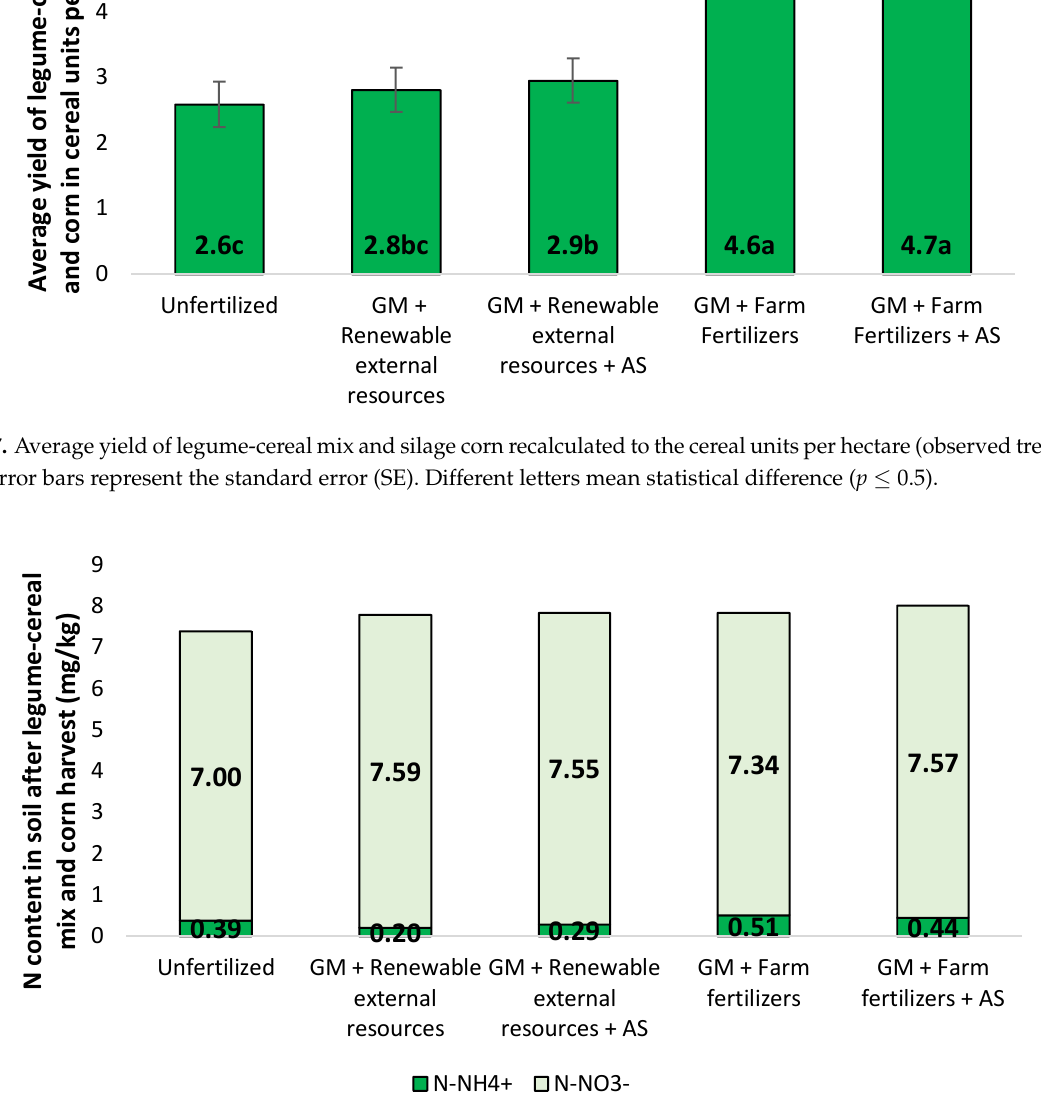
Figure 8. Content of mineral nitrogen after the harvest of legume-cereal mix and corn (observed treatments, 2018).